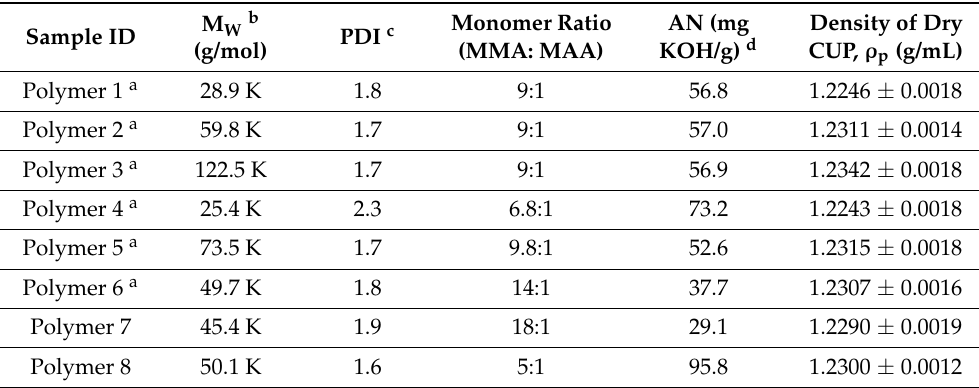
Table 2. Acid number, densities, molecular weight, and polydispersity index of the